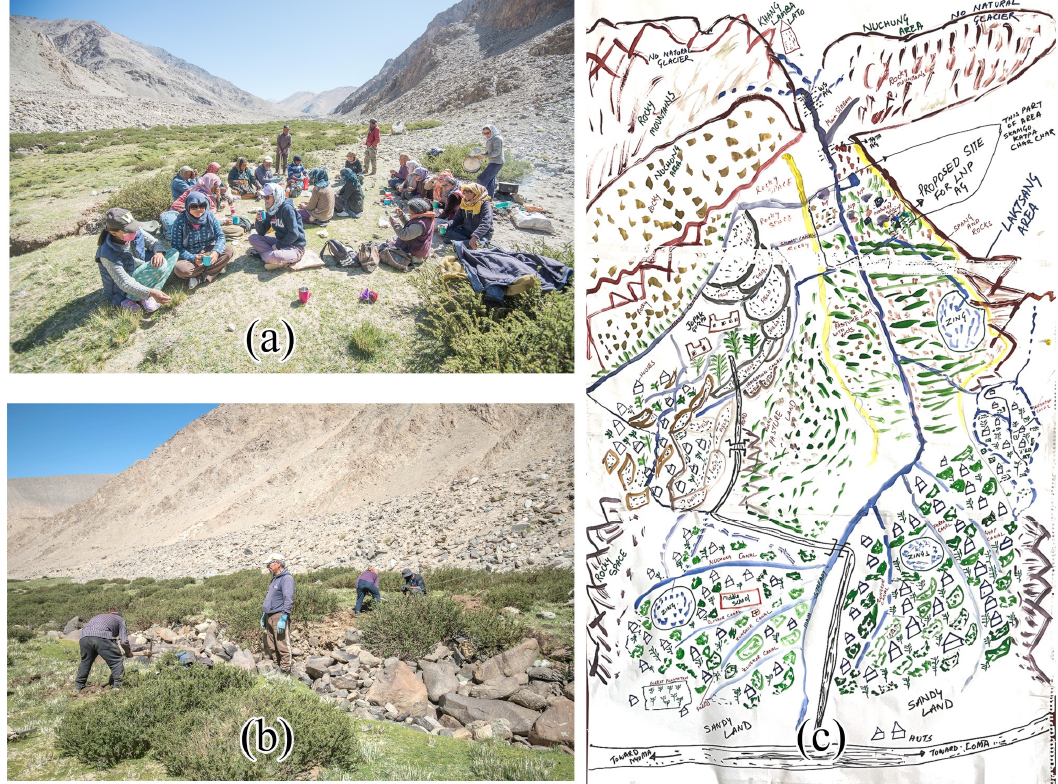
Figure 7. Implementation of Artificial glacier project in Mudh Village by LNP (Source: Authors). ( a ) Villagers meeting at the site of Artificial glacier before beginning of its construction, ( b ) Villagers excavating foundation Artificial glacier, ( c ) A map of Mudh village prepared by the villagers with support from LNP NGO staff to locate the Artificial